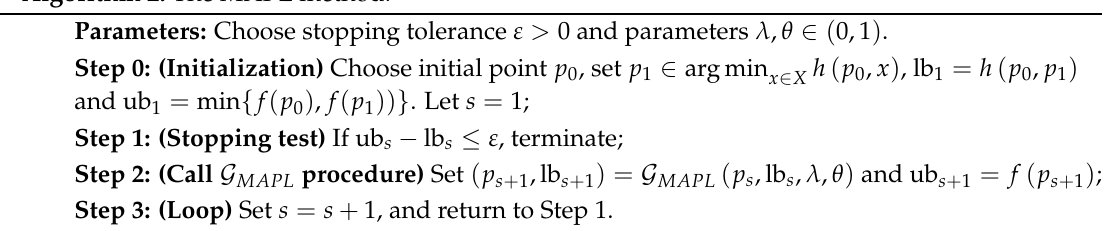
Algorithm 2: The MAPL